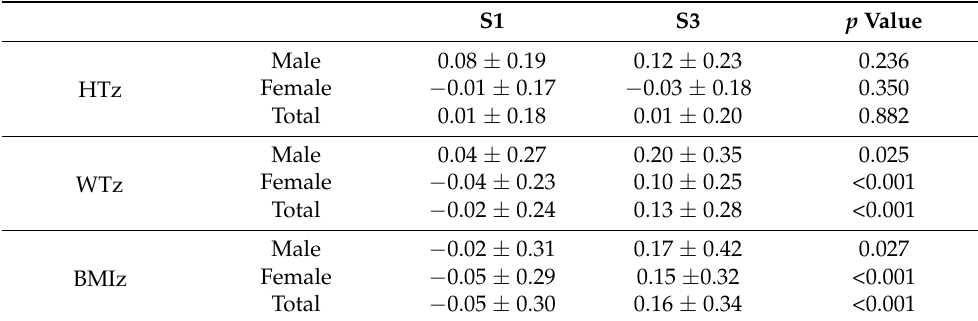
Table 3. The comparisons of z-scores by spring season (S1 (2019 spring) vs. S3 (2020 spring)) using paired t -test.